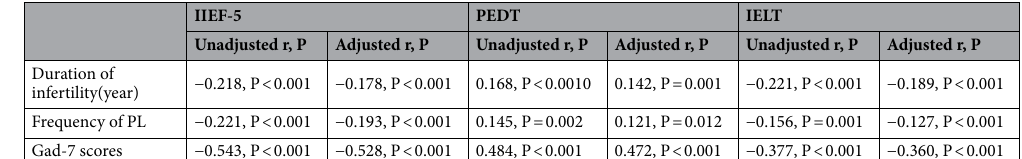
Table 3. Associations between IIEF-5 scores, PEDT scores, IELT and duration of infertility, frequency of PL and anxiety. All adjusted by age. PEDT premature ejaculatory diagnostic tool, IIEF-5 International Index of Erectile Function, IELT intravaginal ejaculatory latency